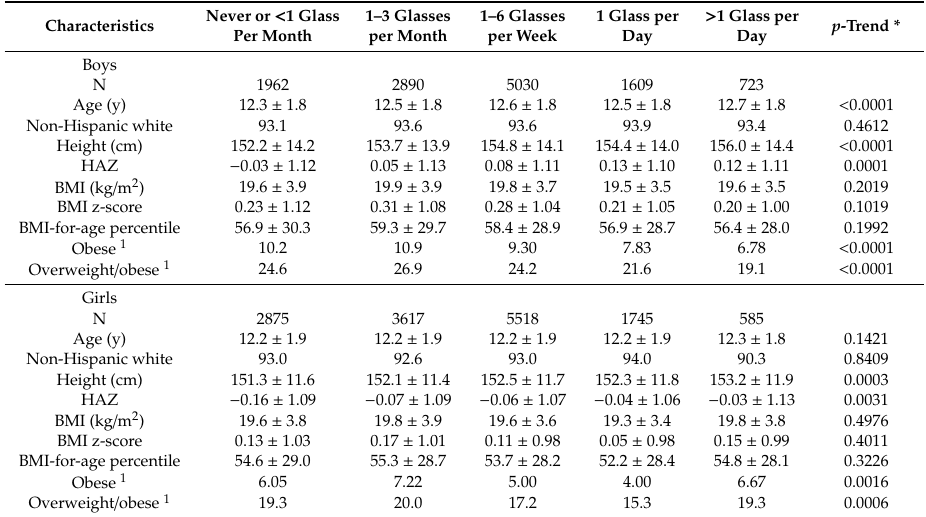
Table 2. Baseline demographic and anthropometric characteristics of the GUTS I and II participants by level of 100% OJ consumption (mean ± SD, or